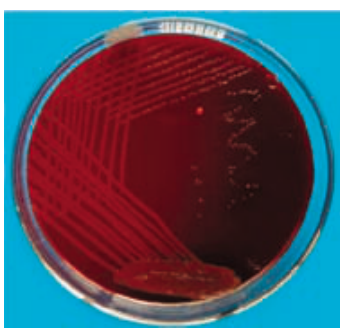
Fig. 6. Inhibition of biofilm by capsaicin in combination with norfloxacin